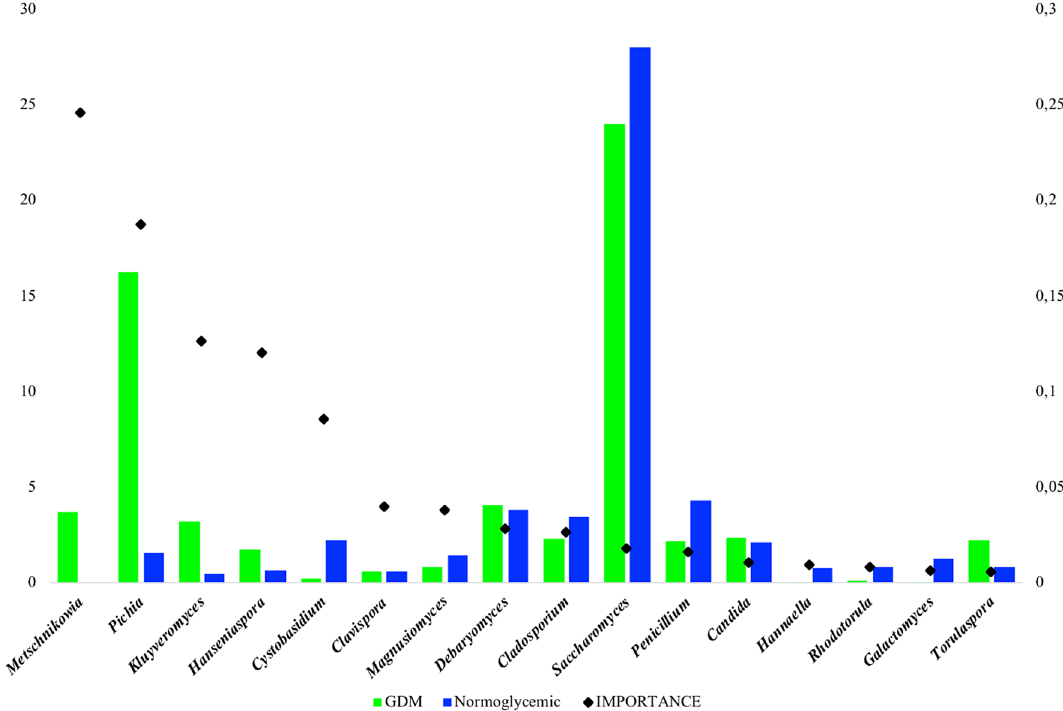
Figure 4. List of the ASVs discriminating GDM from normoglycemic women. For each ASV, the average percentage of frequency is represented by a bar, color-coded according to the groups (left scale). The importance in discriminating of each ASV is represented by a black dot (right